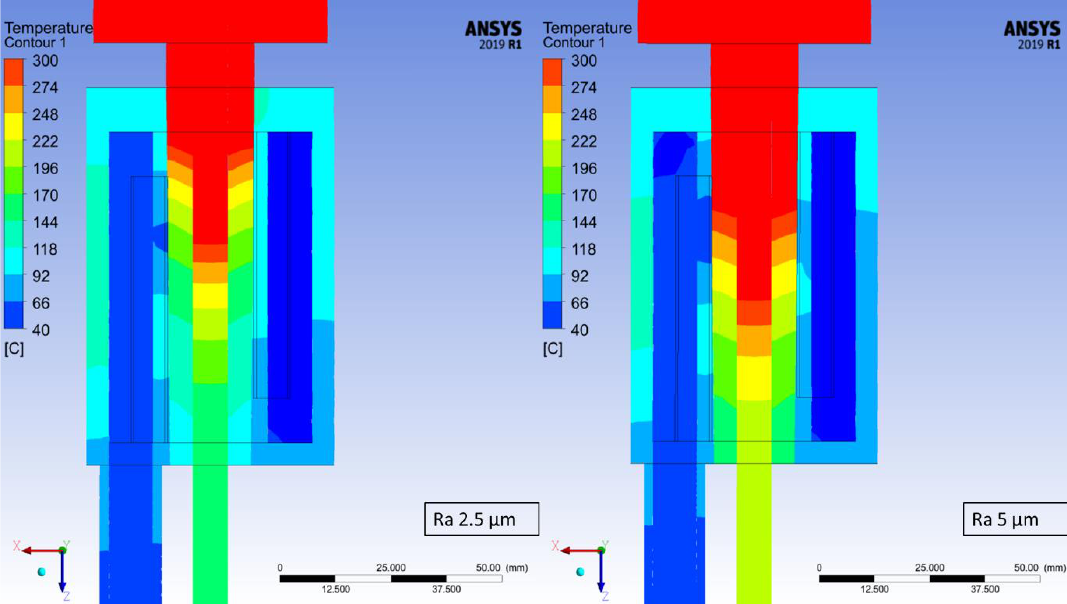
Figure 9. Continuous casting process simulation for the crystallizer with Ra 2.5 μm ( left ) and Ra 5 μm ( right ); step 900 of the simulations (450 s). Table 1. Collective measurements data recorded during the finite element method simulations of the continuous casting process. Crystallizer